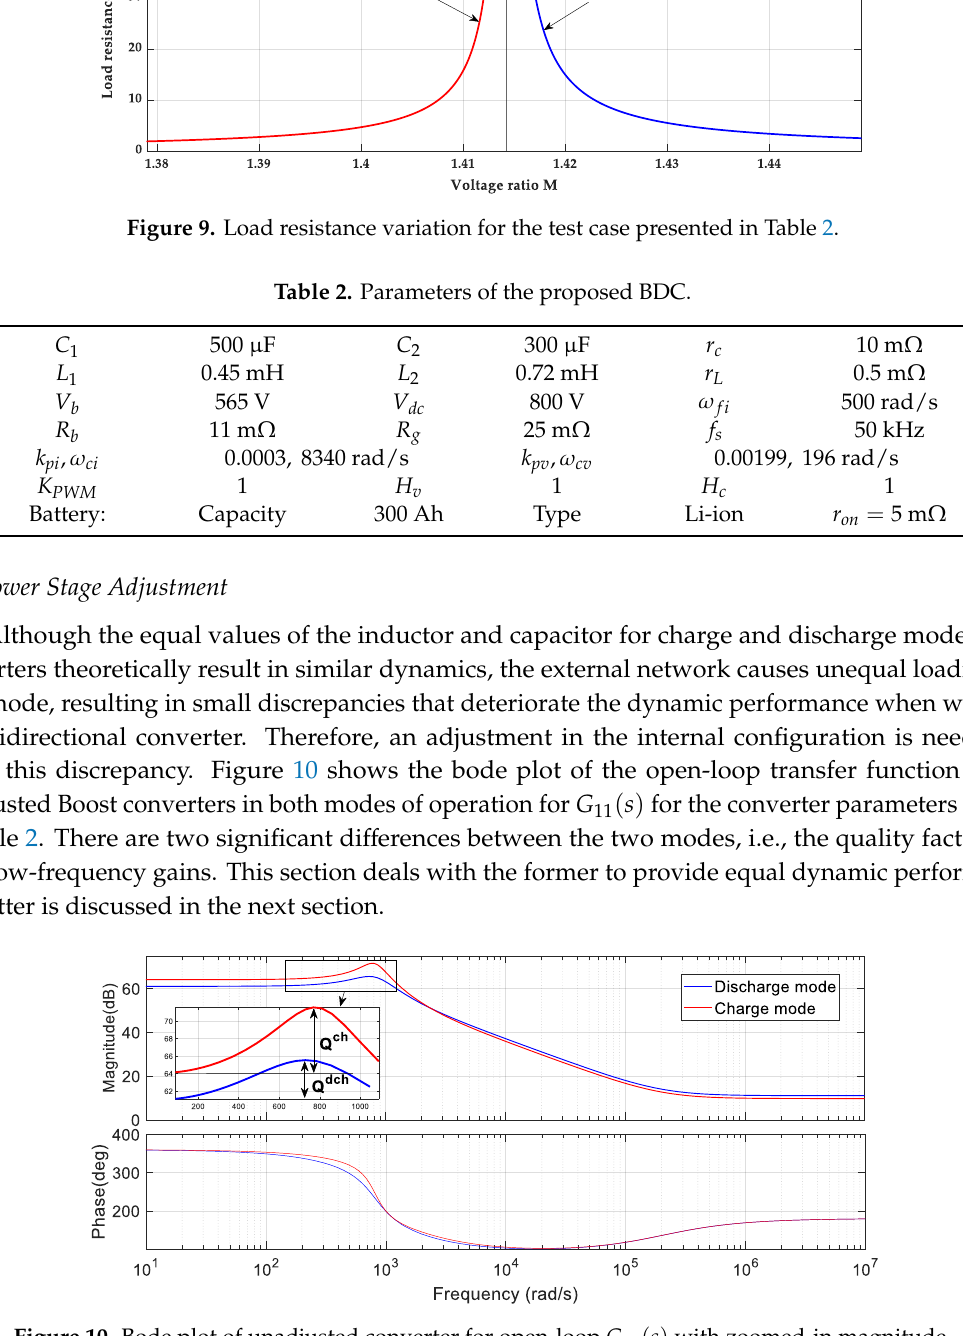
Figure 10. Bode plot of unadjusted converter for open-loop 𝐺 11 (𝑠) with zoomed-in magnitude.